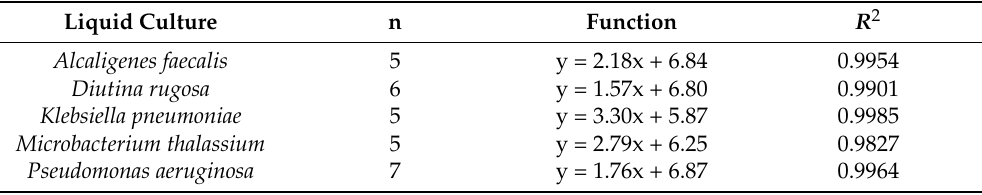
Table 3. Linear regression model of log 10 (CFU · mL − 1 ) and OD 600 from liquid cultures of puta- tive entomopathogenic bacterial ( A. faecalis , K. pneumoniae , M. thalassium , P. aeruginosa ) and yeast ( D. rugosa )